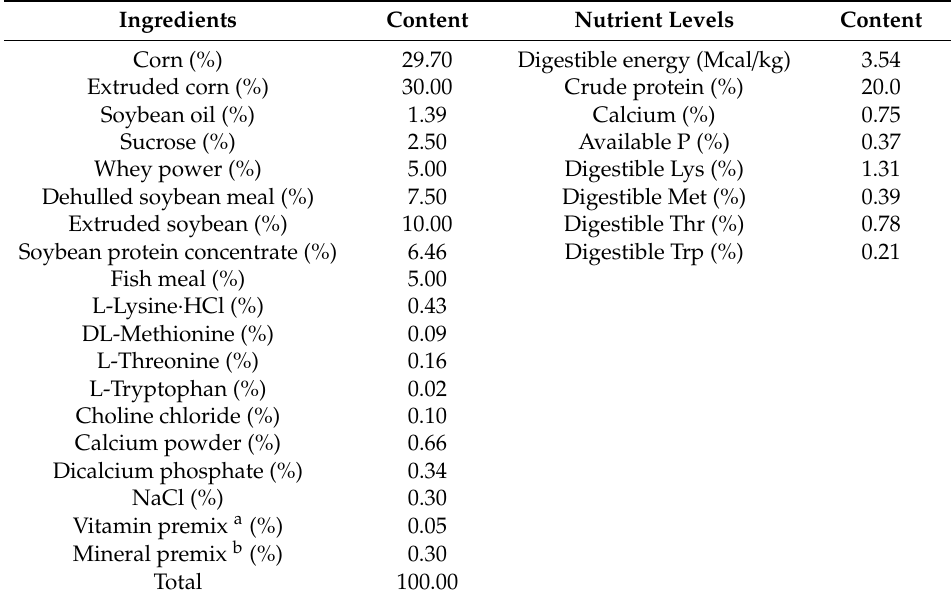
Table A1. Composition and nutrient levels of the basal